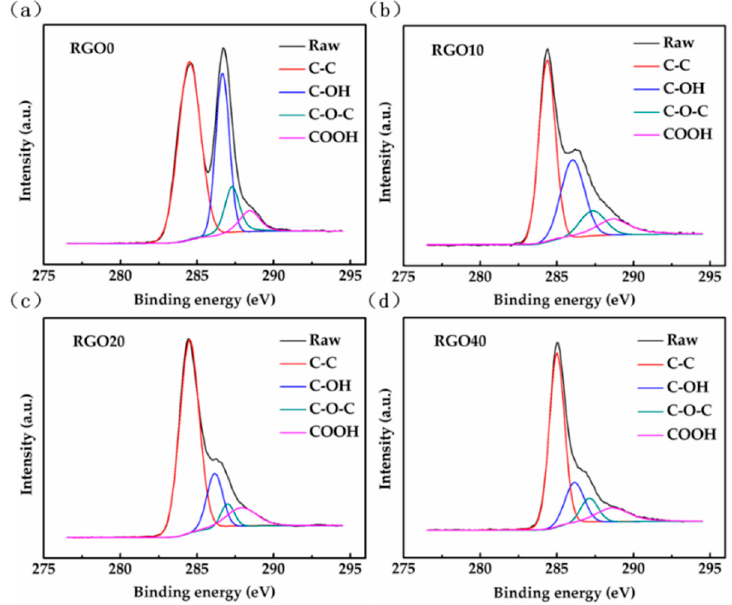
Figure 5. XPS spectra of Gaussian fitted peaks of ( a ) RGO0; ( b ) RGO10; ( c ) RGO20; and ( d ) RGO40, respectively.